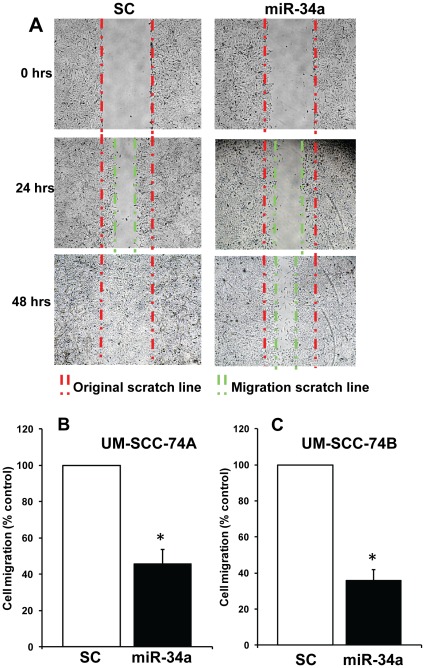
miR-34a significantly inhibits tumor cell migration.
A: Tumor cell (UM-SCC-74A) motility was examined by scratch assay. Red dotted lines mark the edges at the start of experiments, and green dotted lines mark the edges at the end of experiments. B-C: Tumor cell migration was analyzed by Xcelligence system. Percentage cell migration for cells ectopically expressing miR-34 was calculated by adjusting migration index for tumor cells transduced with SC to 100%. *, represent a significant inhibition (p<0.05) of cell migration in miR-34a expressing tumor cells as compared to SC.